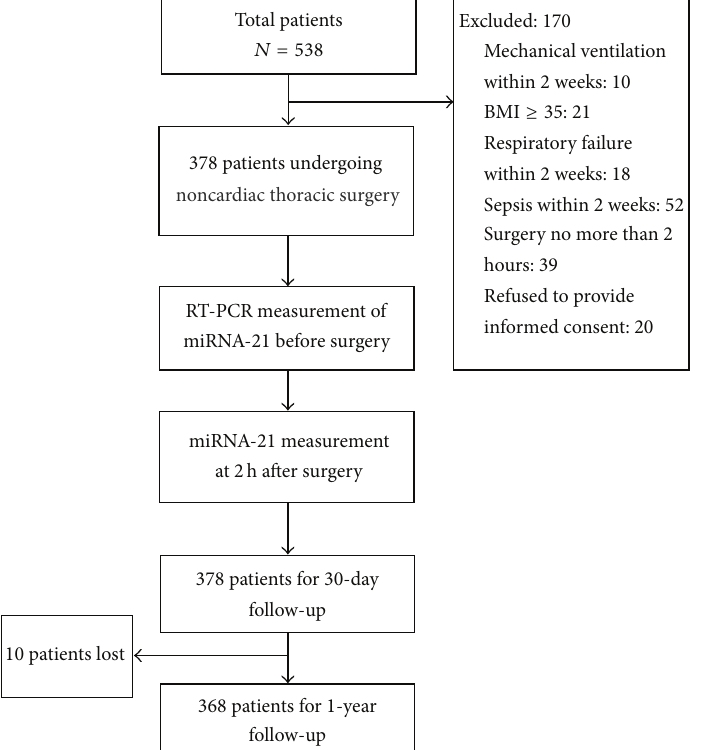
Figure 1: Study design and flow chart. Totally 538 patients were recruited and 170 were excluded. Ten patients were lost during 1-year follow- up. Ultimately 368 patients finished the study.